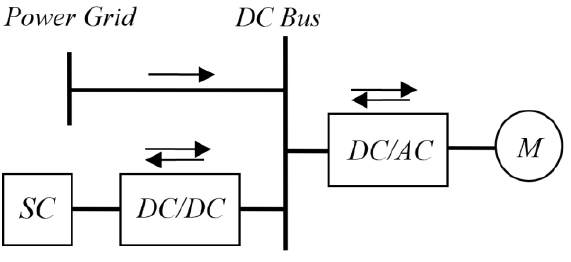
Figure 9. Combined traction drive system with DC mains as the main power source.